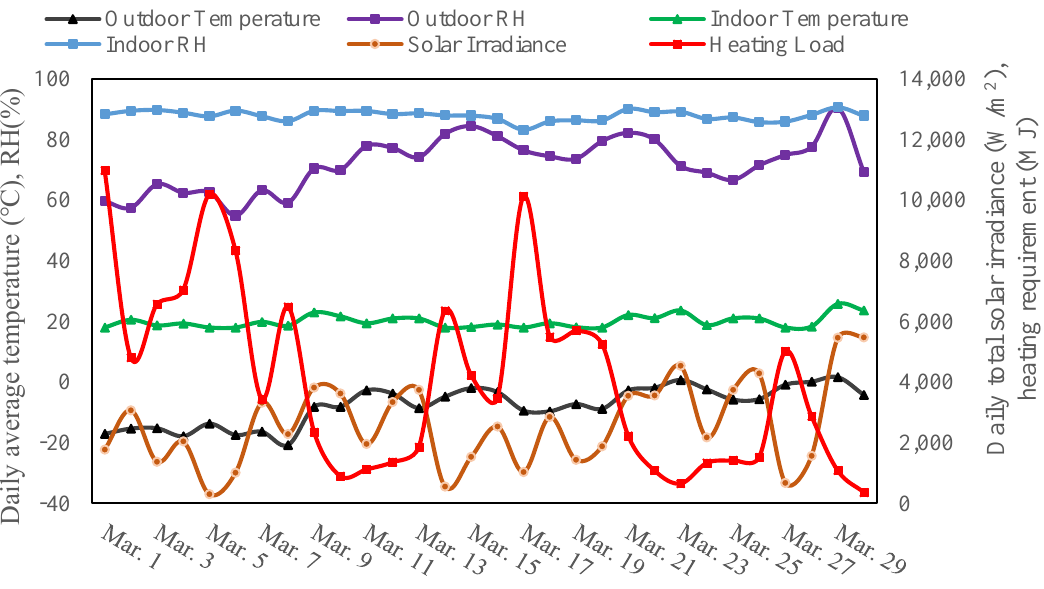
Figure 13. Daily average indoor conditions, solar irradiance, and heating loads in March. In July, as shown in Figure 14, the average daily indoor temperature ranged between 22 to 28 ◦ C, and RH fluctuated in an extensive range due to the air exchange rate changing from infiltration at night to high ventilation rate during the daytime. The daily total solar irradiance was high, and a sun blocker is considered to protect the tomato plants. Supplemental heating is not required except for the early morning on 25 July when the ambient temperature is below 10 ◦ C, and the thermal blanket is rolled